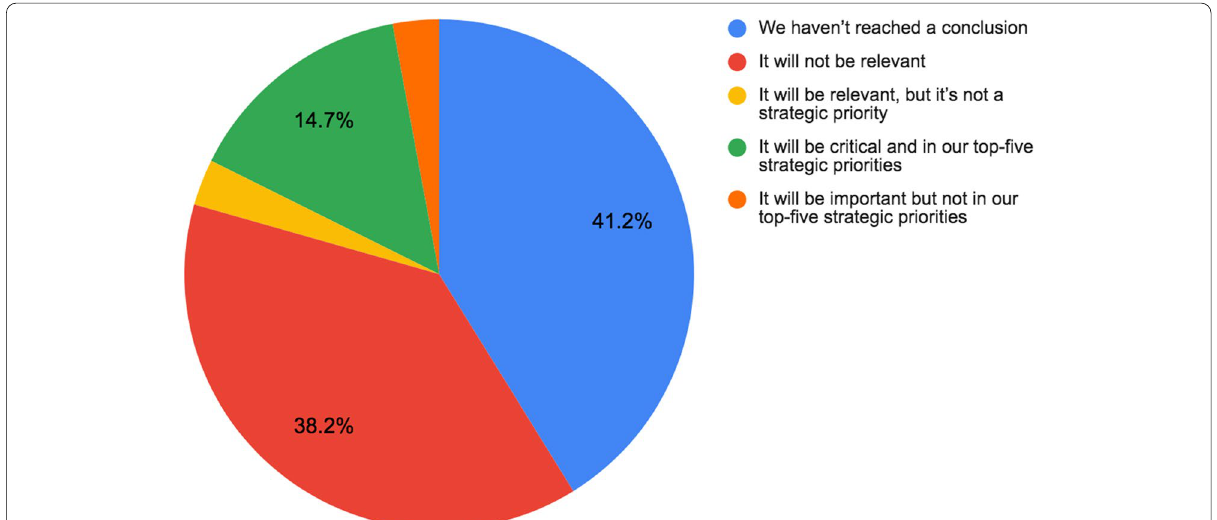
Fig. 3 Blockchain strategies among the Kyrgyz companies. Note . Majority of business-respondents are not planning to include blockchain into their business strategies. N =